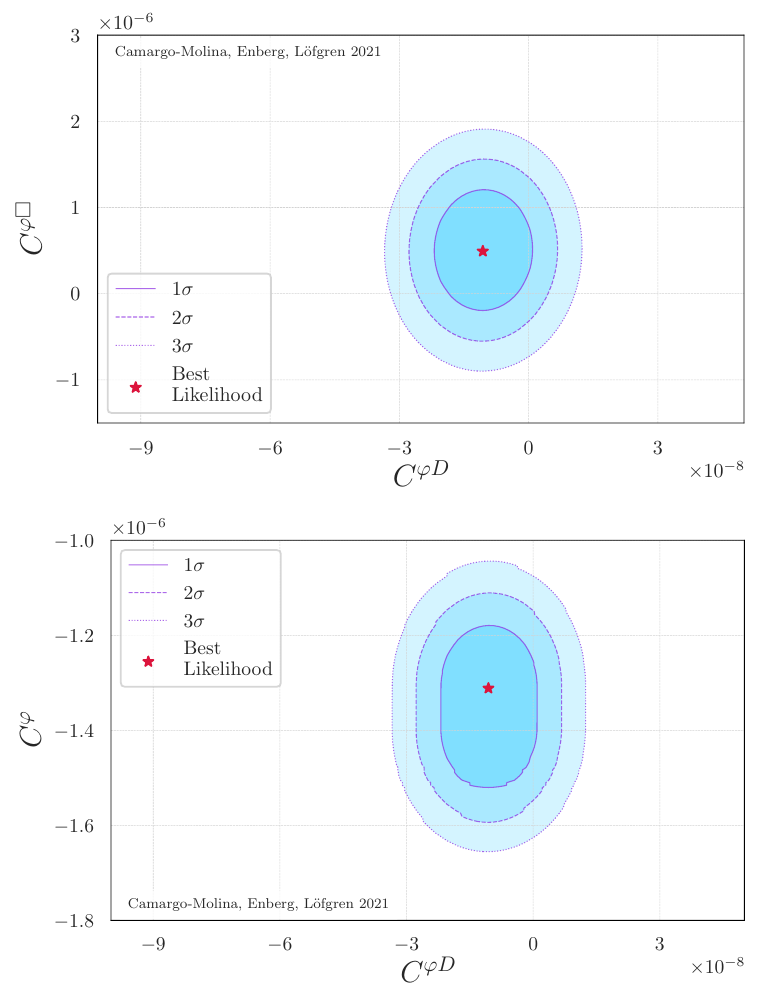
Figure 2 . Profile likelihood for the C ϕD – C ϕ (cid:3) (top) and C ϕD – C ϕ (bottom) planes for points leading to a strongly first order phase transition. One-, two- and three- σ contours are drawn with full, dashed and dotted lines respectively. The point with the best likelihood and a strong FOPT is shown with a